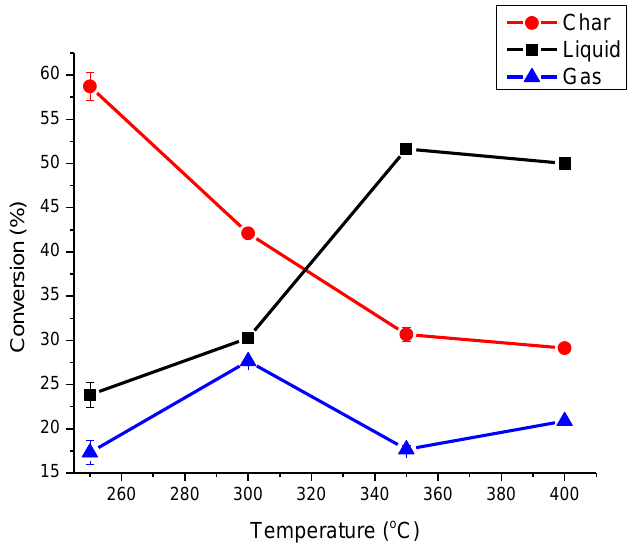
Figure 1. Temperature Optimization for Catalytic Cracking of Tube Rubber.